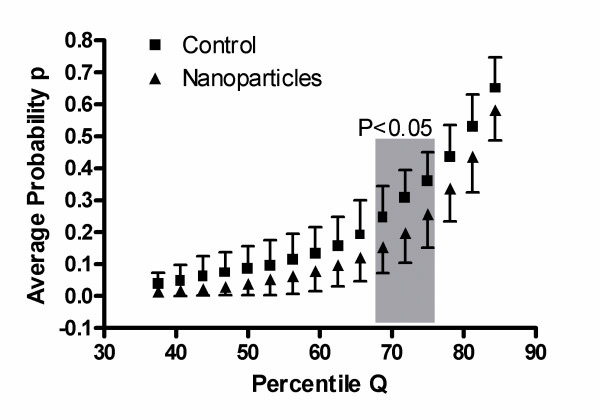
Average probability p (error bars indicate standard deviation) that a run falls into the Q longest runs. The gray shaded area indicates the percentile region where the difference between control images and nanoparticle images is statistically different.